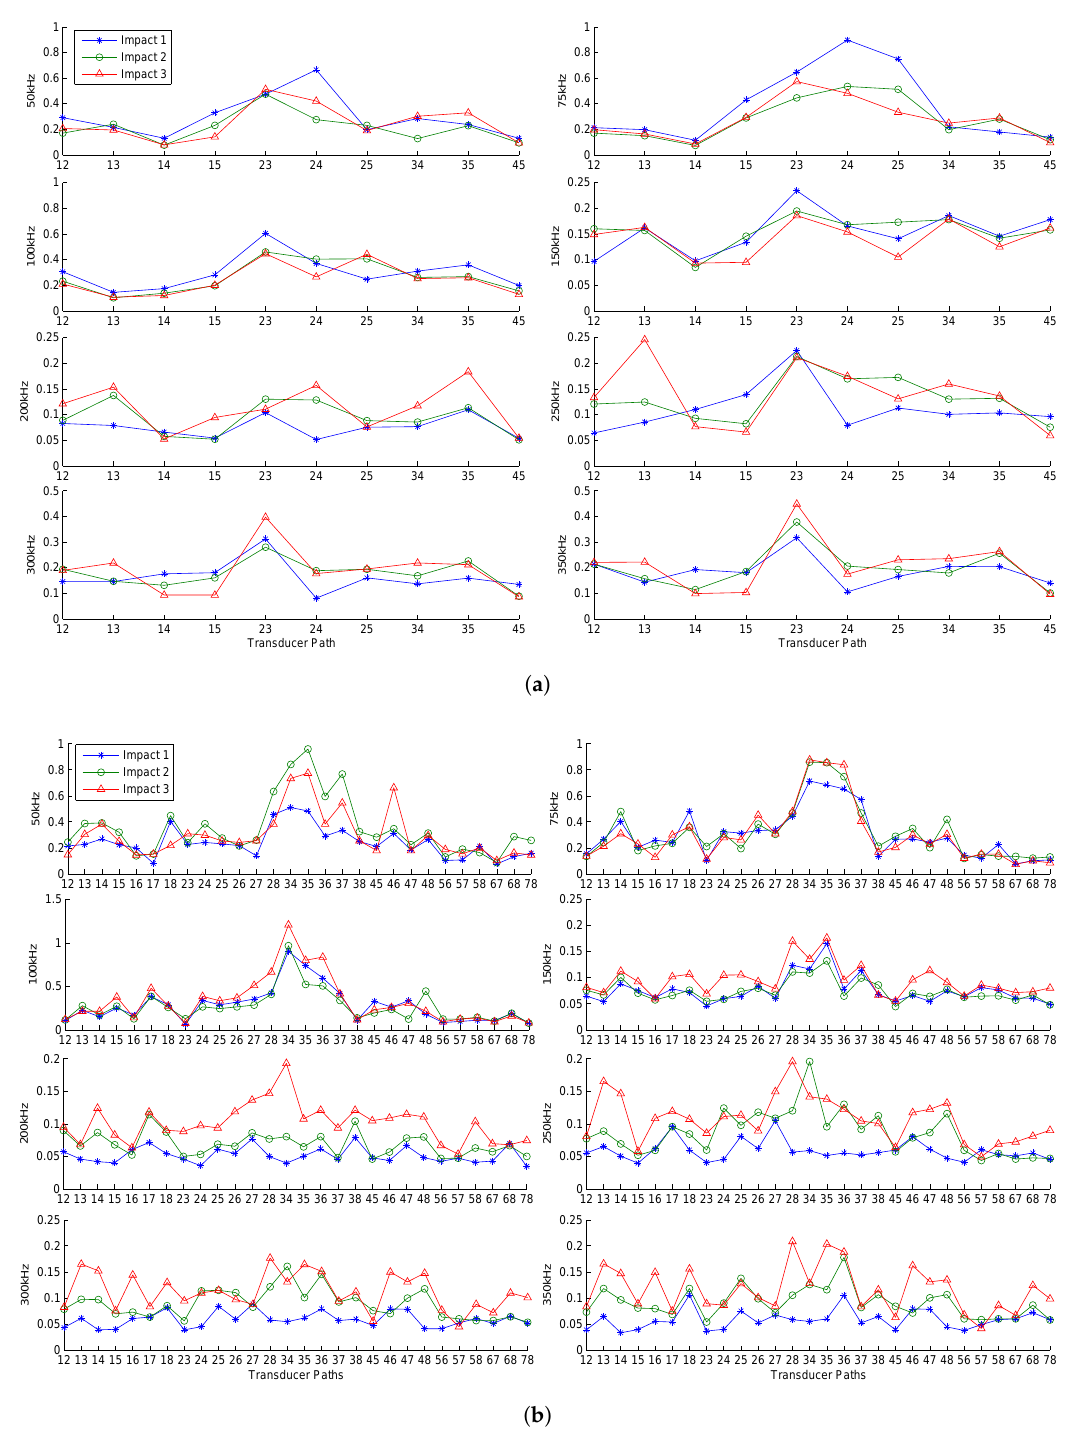
Figure 18. Normalised residual for the CFRP plate with ( a ) the SHM layer and ( b ) the DuraAct transducer after three impact events. Residual as a ratio of the largest amplitude in the waveform